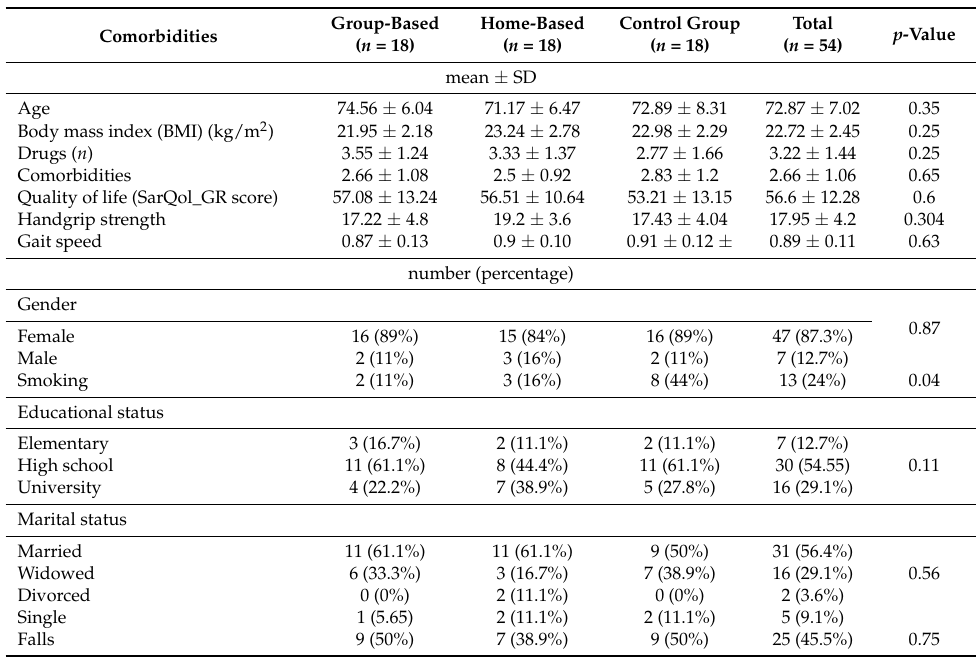
Table 2. Baseline characteristics of sarcopenic participants ( n = 54). SarQoL_GR: Sarcopenia Quality of